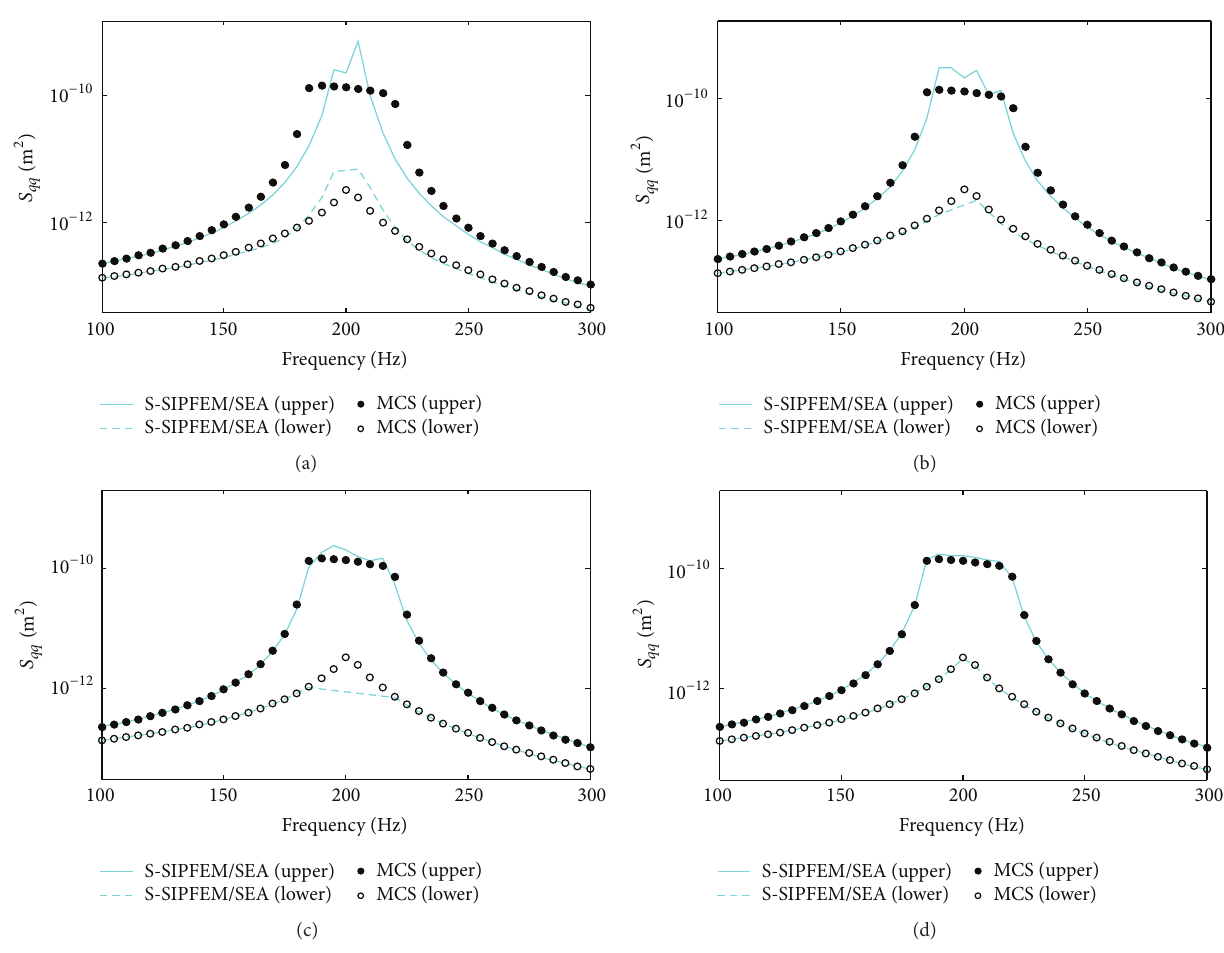
Figure 5: The bounds of the autospectra of the mass displacements: (a) one subinterval, (b) two subintervals, (c) four subintervals, and (d) eight subintervals.